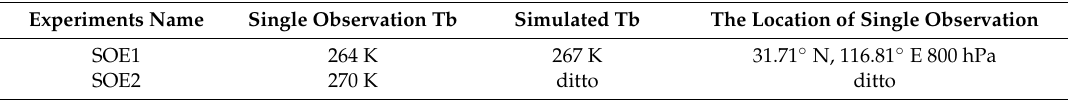
Table 3. Design of single observation